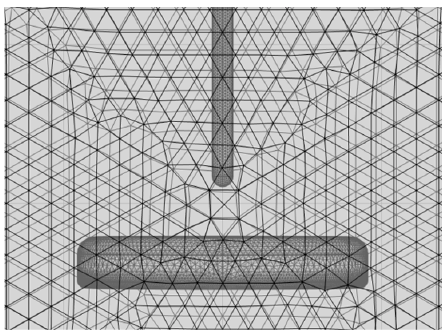
Figure 19. The mesh form of rod (R = 6 mm)–plane electrode system.